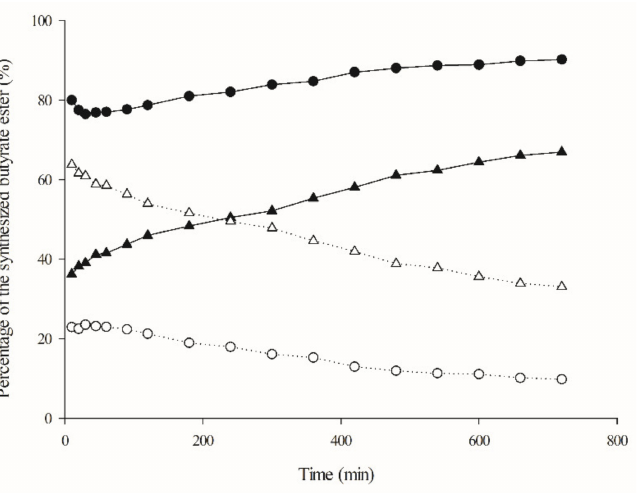
Figure 6. Percent composition of the butyrate esters obtained from 3-methylbutanol (solid line, black symbols) and 2-methylbutanol (dotted line, white symbols) in commercial isoamyl alcohol (circles) and fusel oil